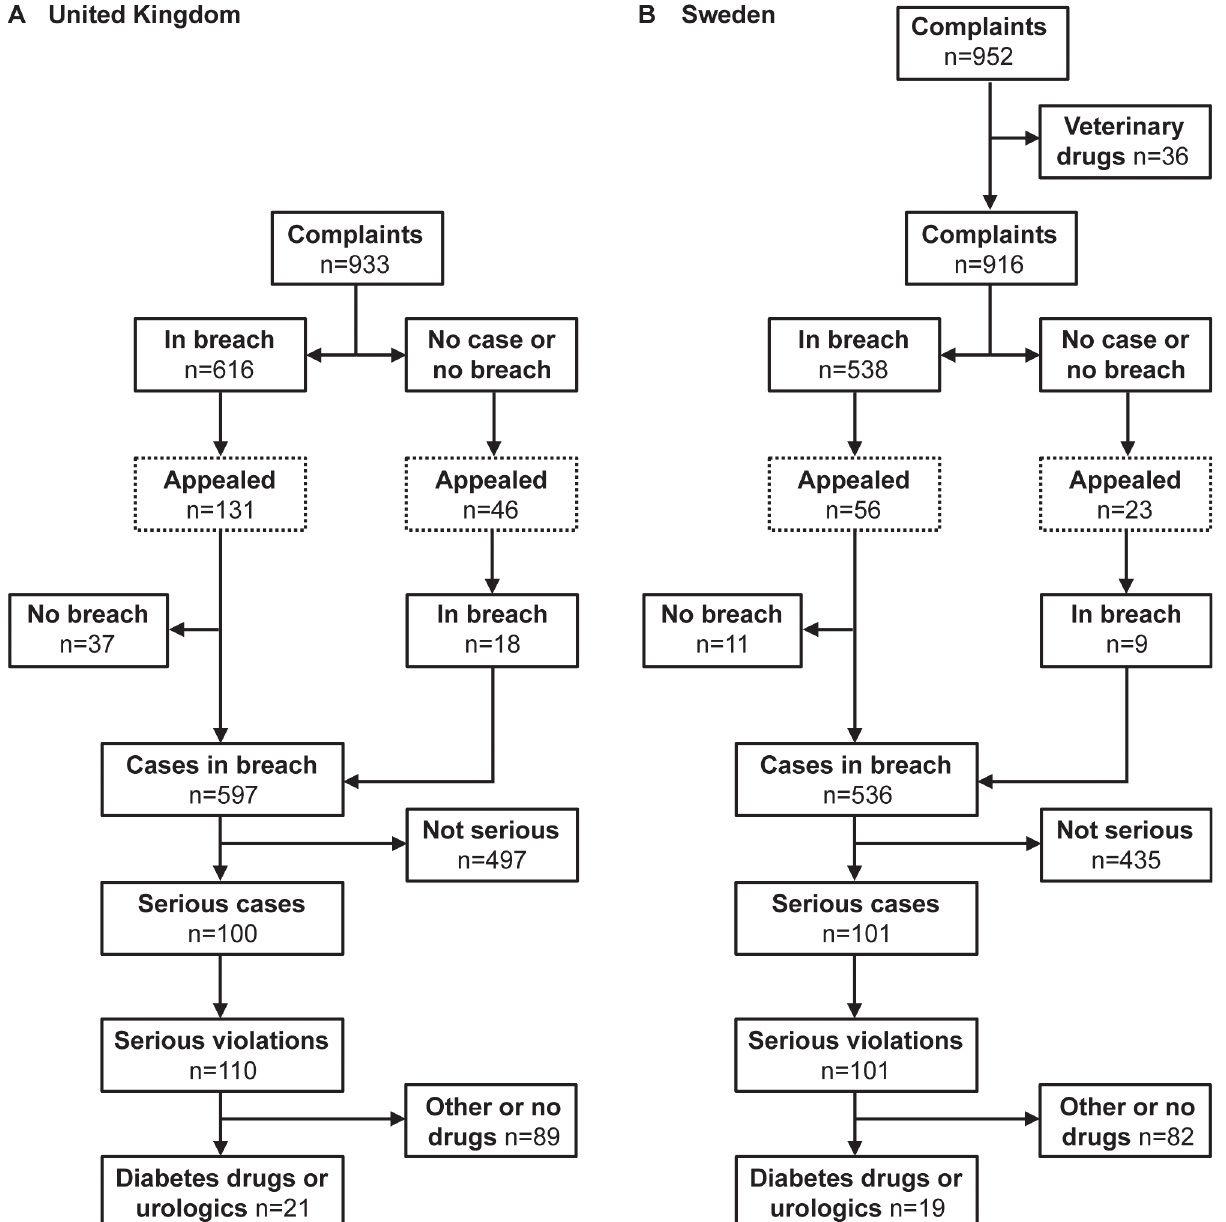
Fig 2. Flow diagram of selected complaints, cases, and violations in the United Kingdom (A) and Sweden (B) 2004 –